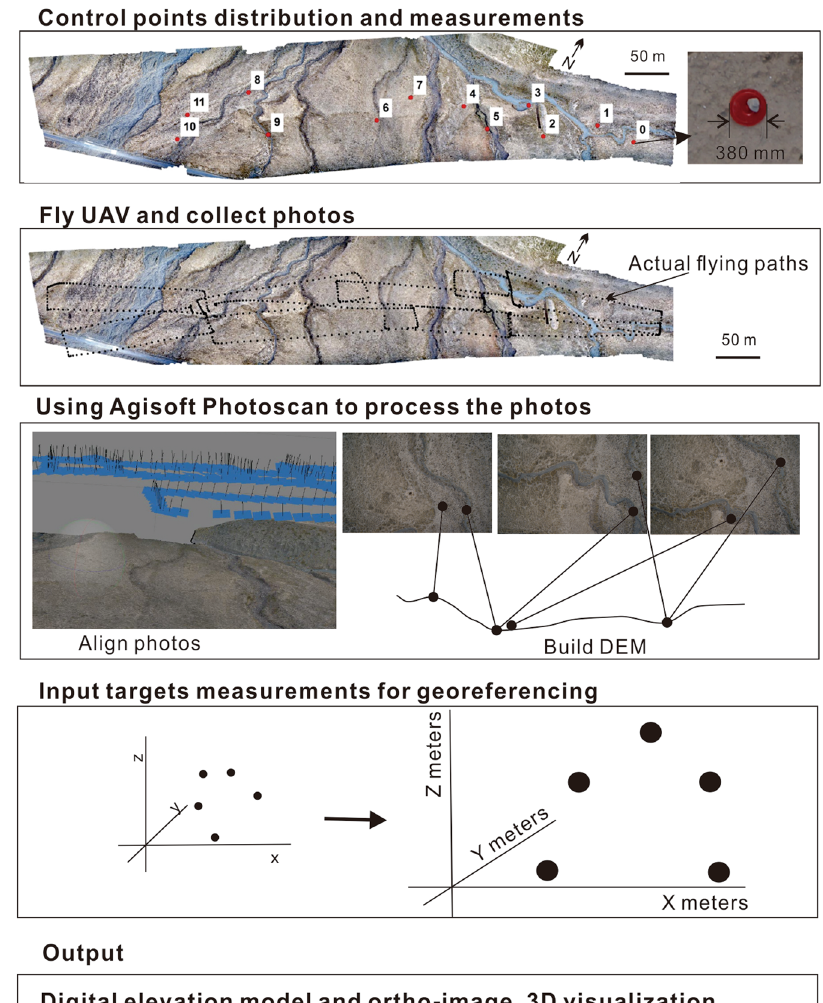
Figure 5. Schematic illustration of the workflow of photo-based mapping procedures using a UAV and the Agisoft Photoscan software. Control points (red dots) were measured using a Trimble handheld GPS with a high-sensitivity GPS